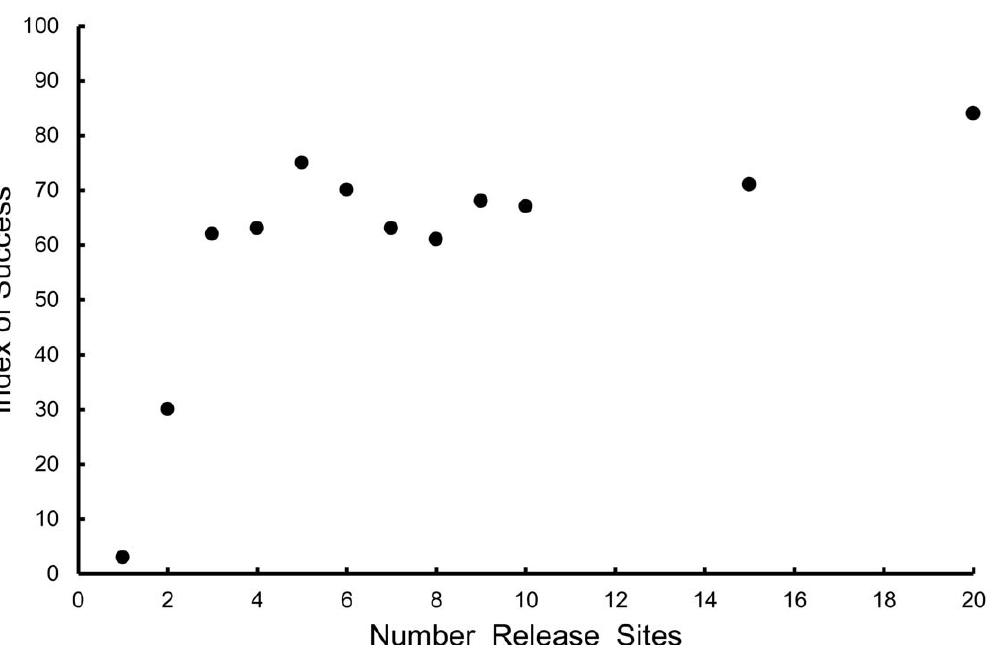
Figure 4. Predicted relationship between the number of release sites for a translocation and reintroduction success. Points represent mean values for 100 simulations.